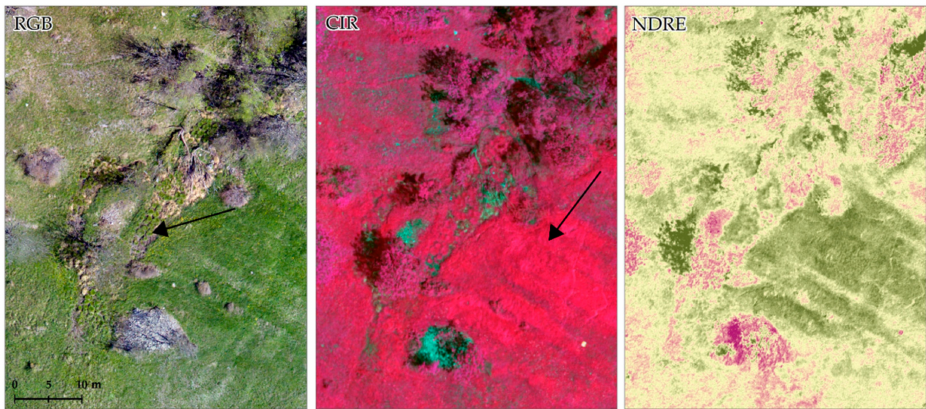
Figure 10. RGB ( left ), CIR ( center ) and NDRE ( right ) of a portion of the investigated landslides revealing hummock-and-hollow pattern ( ← RGB) and long leaf grass lodging ( ← CIR) as indicators of water